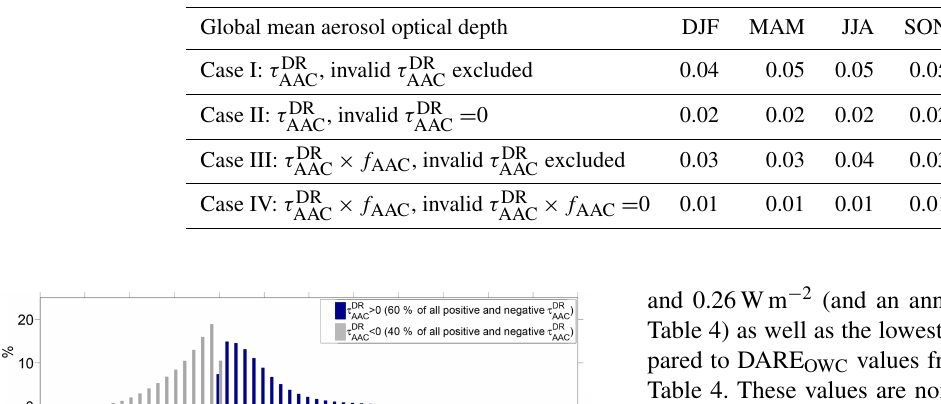
Figure 2. Global seasonal 4 ◦ × 5 ◦ nighttime AAC occurrence frequency (noted f AAC ; see Eq. 3) from 2008 to 2012. White pixels show either no CALIOP observations, a limited number of CALIOP unobstructed OWCs or a limited number of positive τ DR are not considered in the global mean and median f AAC values in the title of each map. The title of each map shows the global maximum, median and mean values. Table 3. Global seasonal and annual averages of τ DR cases are excluded from the averages (Case I and III) or (ii) τ DR Annual averages here (last column) are the mean of the seasonal averages.